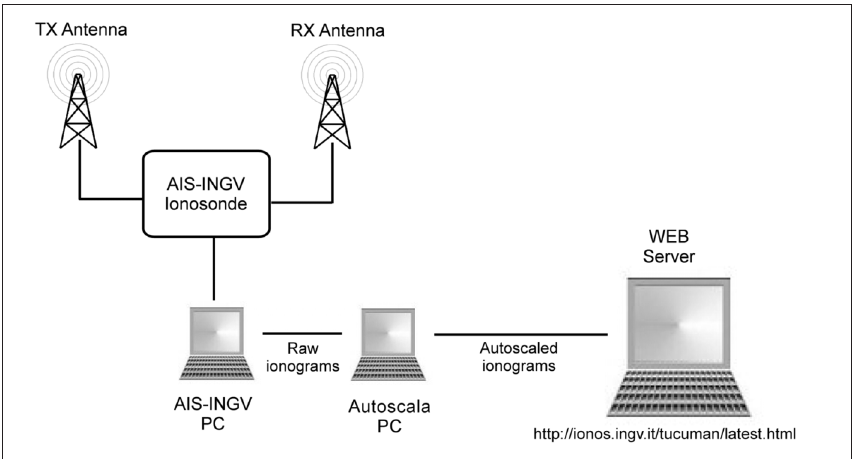
Fig. 2. The AIS-INGV/Autoscala system data